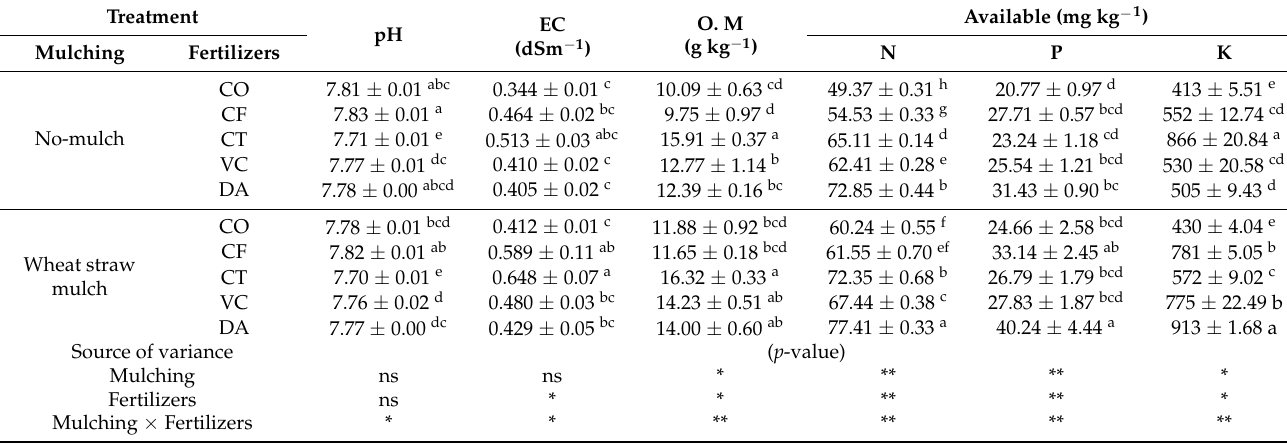
CO = Control (without fertilization), CF = Recommended mineral fertilization (112 kg N ha − 1 + 50 kg P 2 O 5 + 75 kg K 2 O ha − 1 ), CT = Compost (7.5 t ha − 1 ), VC = Vermicompost (7.5 t ha − 1 ), DA = Dry Azolla pinnata (3.75 t ha − 1 ). Different superscript letters in the same column indicate significant differences according to Duncan’s multiple range test at p ≤ 0.05. Data are means of three replicates ± SE. ns = not significant. * p < 0.05, ** p < 0.01, and ns indicates non-significant differences ( p ≥